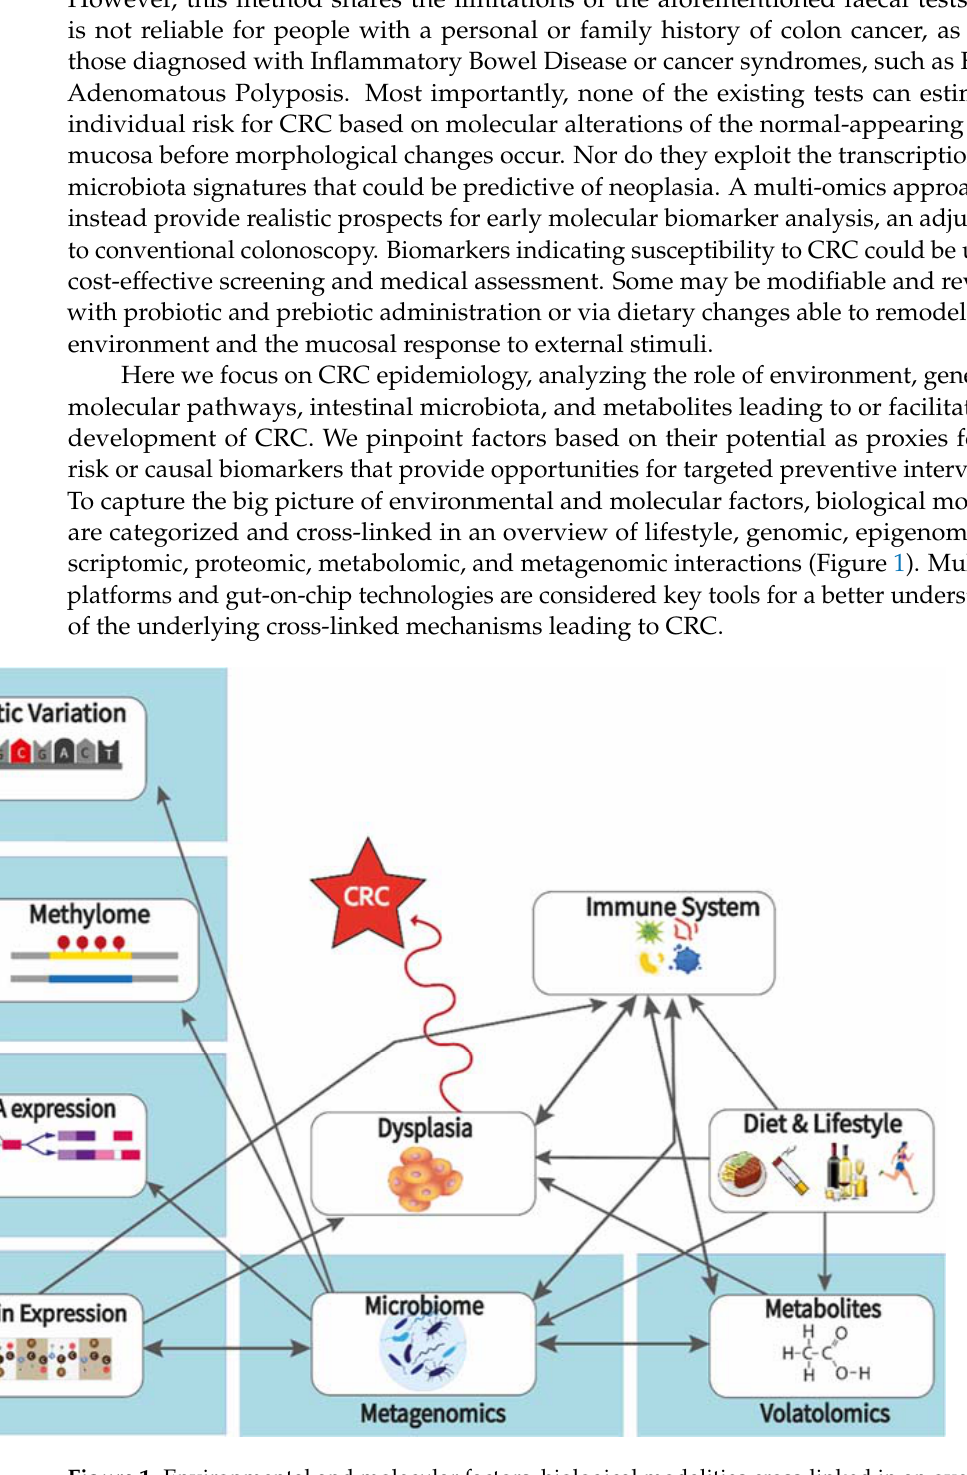
Figure 1. Environmental and molecular factors, biological modalities cross-linked in an overview of lifestyle, genomic, epigenomic, transcriptomic, proteomic, metabolomic, and metagenomic interac- tions leading to CRC-predisposing dysplasia.